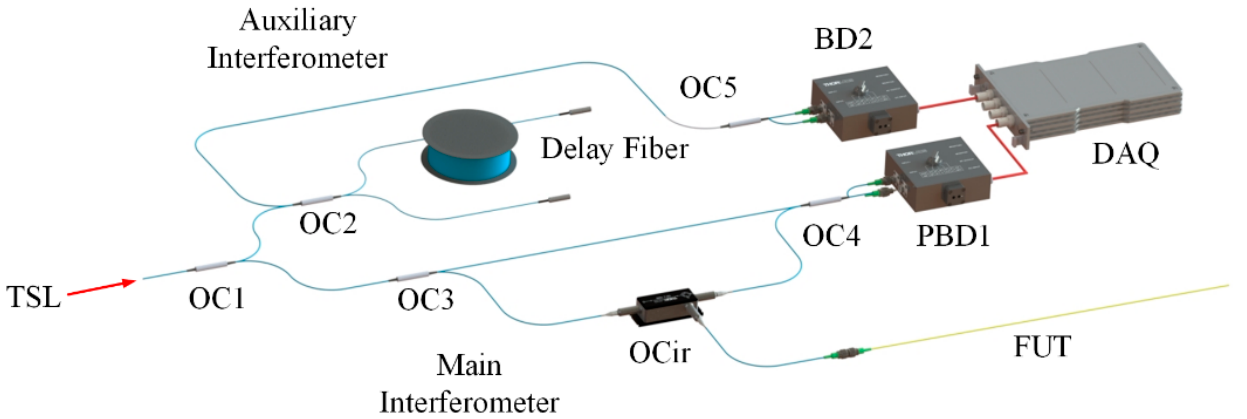
Figure 6. Optical path diagram. TLS—tuning sweep light source; OC—optical coupler; OCir—opti- cal circulator; BD—balance detector; PBD—polarization balance detector; DAQ—data acquisition card; FUT—fiber under text.